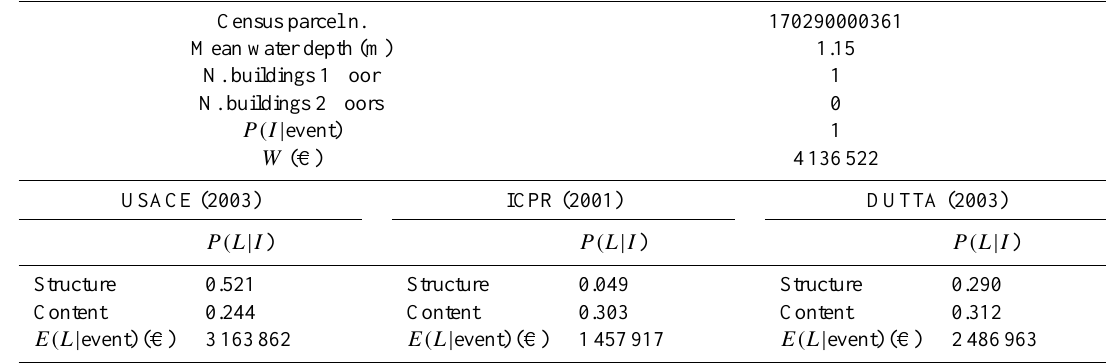
Table 1. Example of the application of the three flood vulnerability models to a census parcel containing one 1-floor non-residential building completely impacted by the flooding corresponding to a return period of 500yr.